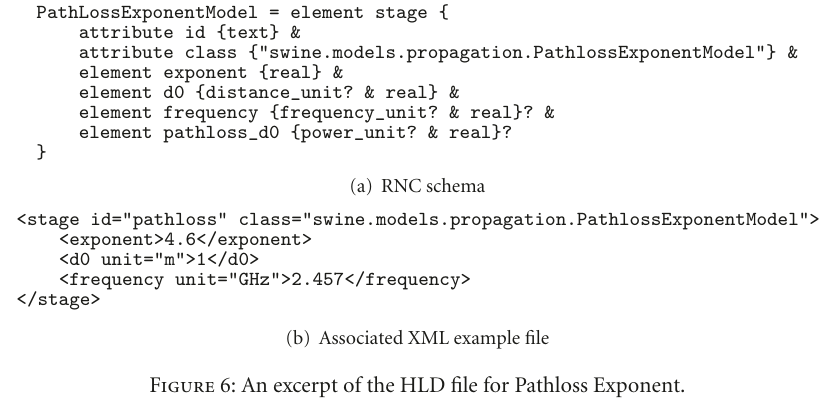
Figure 6: An excerpt of the HLD file for Pathloss